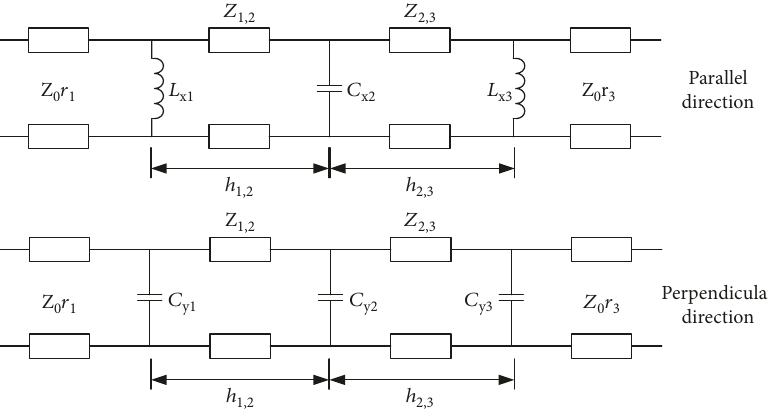
Figure 2: Equivalent circuit model of the proposed FSS